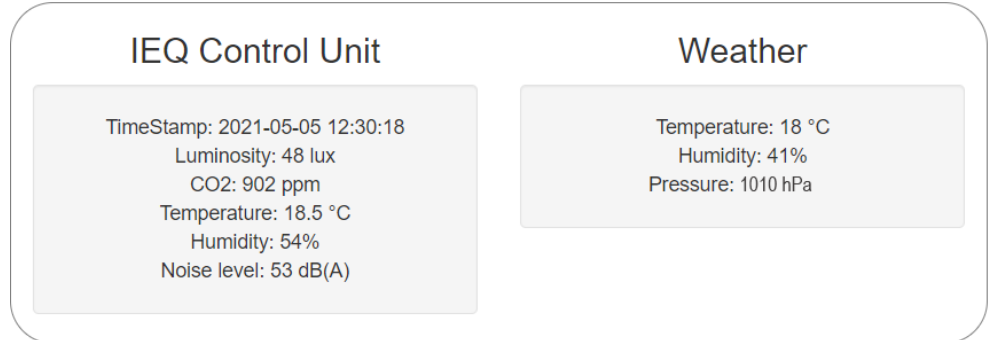
Figure 6. A web page layout example of